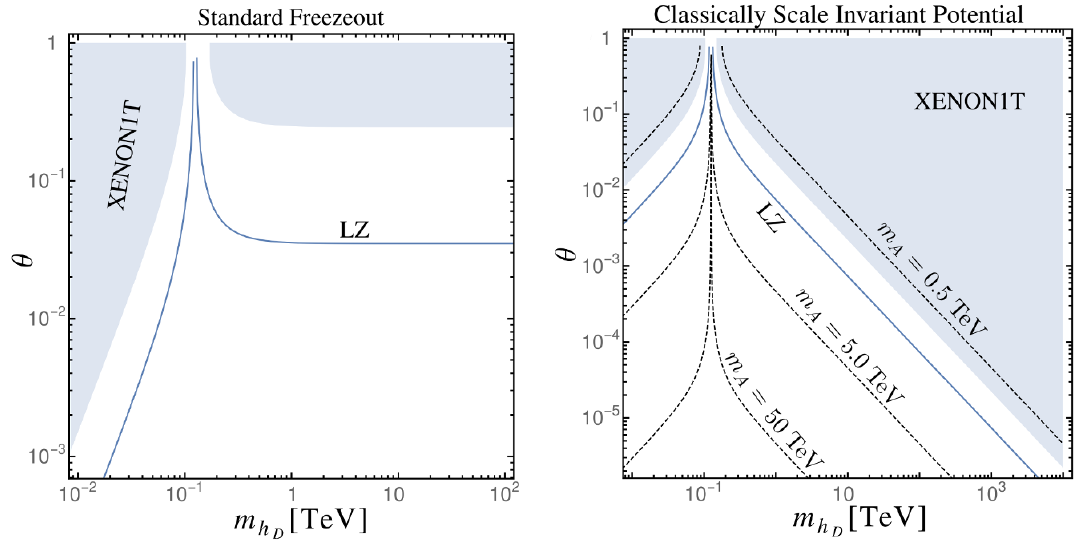
Figure 2 . Mixing angles excluded by Xenon1T [31] (shaded area) together with the projected sensitivity from LZ [32] (solid line). Here we assume m A & 0 : 1 TeV. Left: assuming the relic density is produced via the freeze-out mechanism. Right: for the classically scale invariant potential, including contours for some choices of the DM